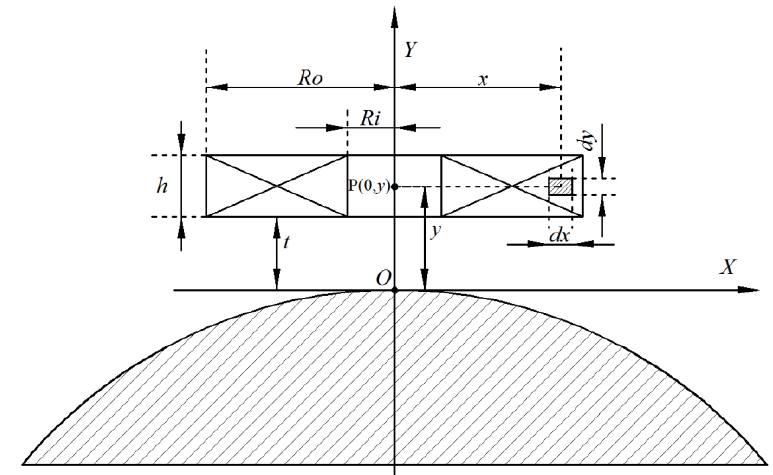
Figure 2. The model of eddy current testing.